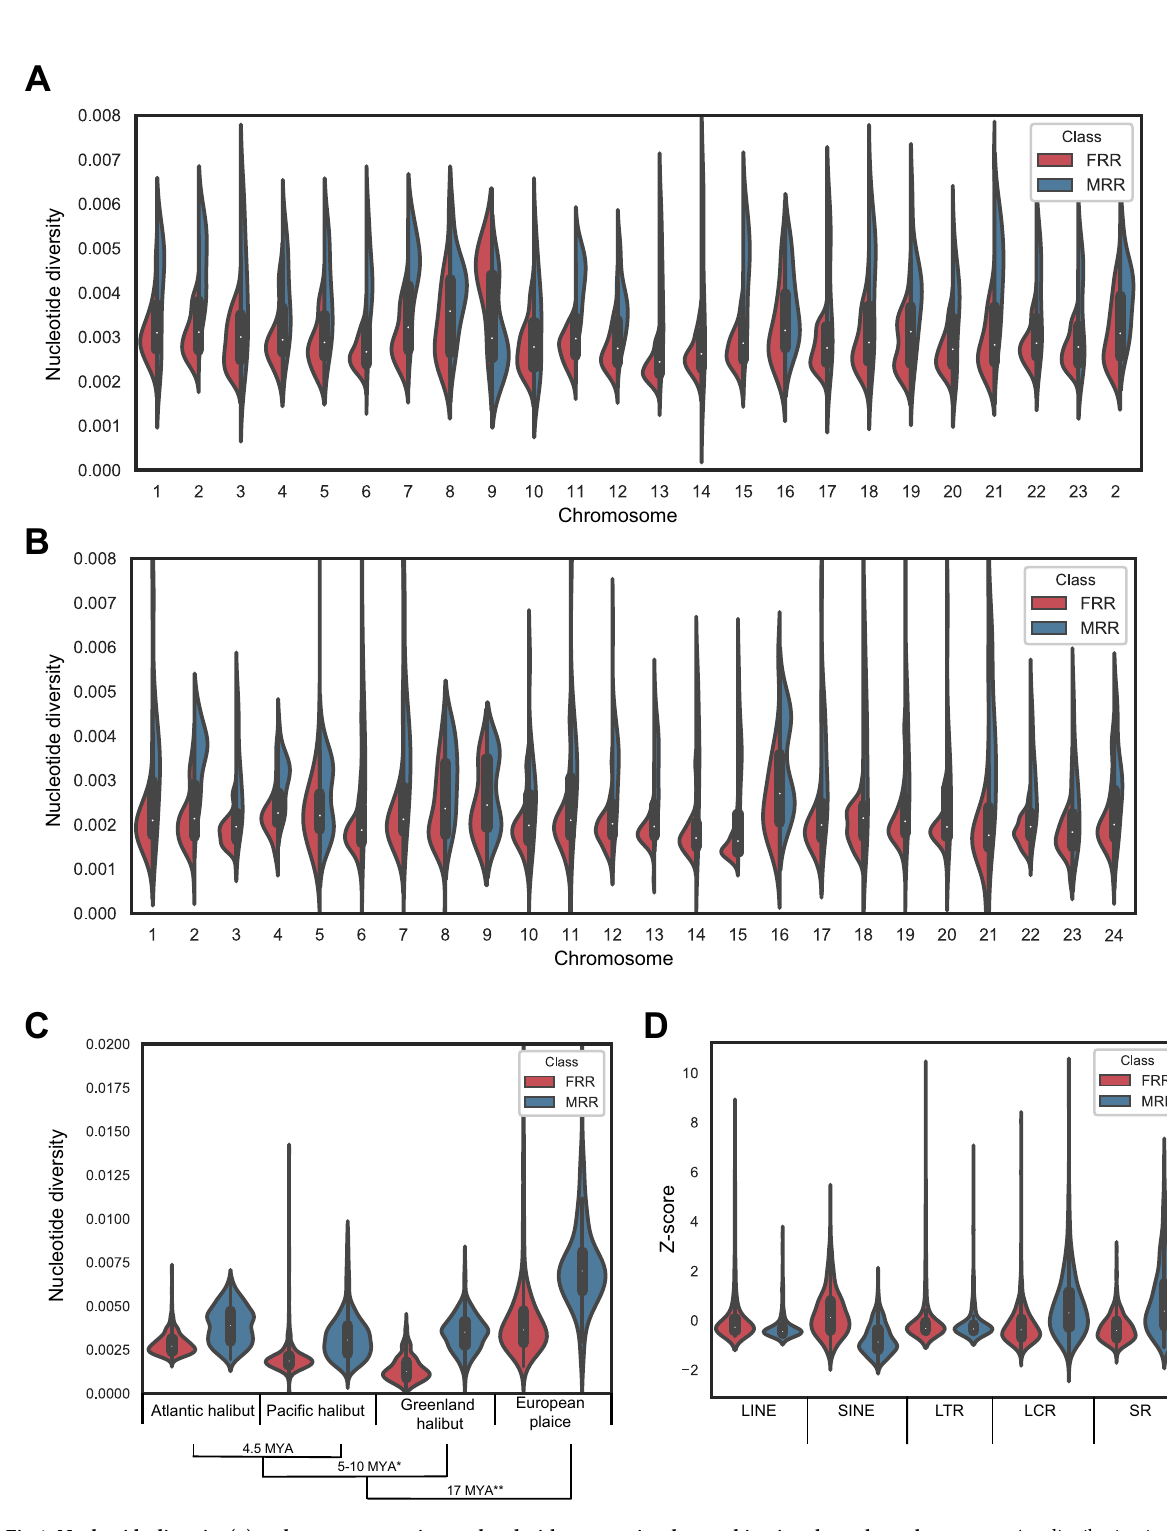
Fig 4. Nucleotide diversity ( π ) and repeat content is correlated with sex-restricted recombination throughout the genome. A π distribution in the Atlantic halibut genome, contrasting regions of male-only vs. female-only meiotic recombination, MRRs and FRRs, respectively. B Distribution of Pacific Halibut π estimates for regions mapped back to the Atlantic halibut genome, classified as either MRRs or FRRs. Chromosomal and MRR/FRR assignments were extracted from the Atlantic halibut genome assembly coordinates. C Genome-wide distributions of estimated π for Atlantic-,